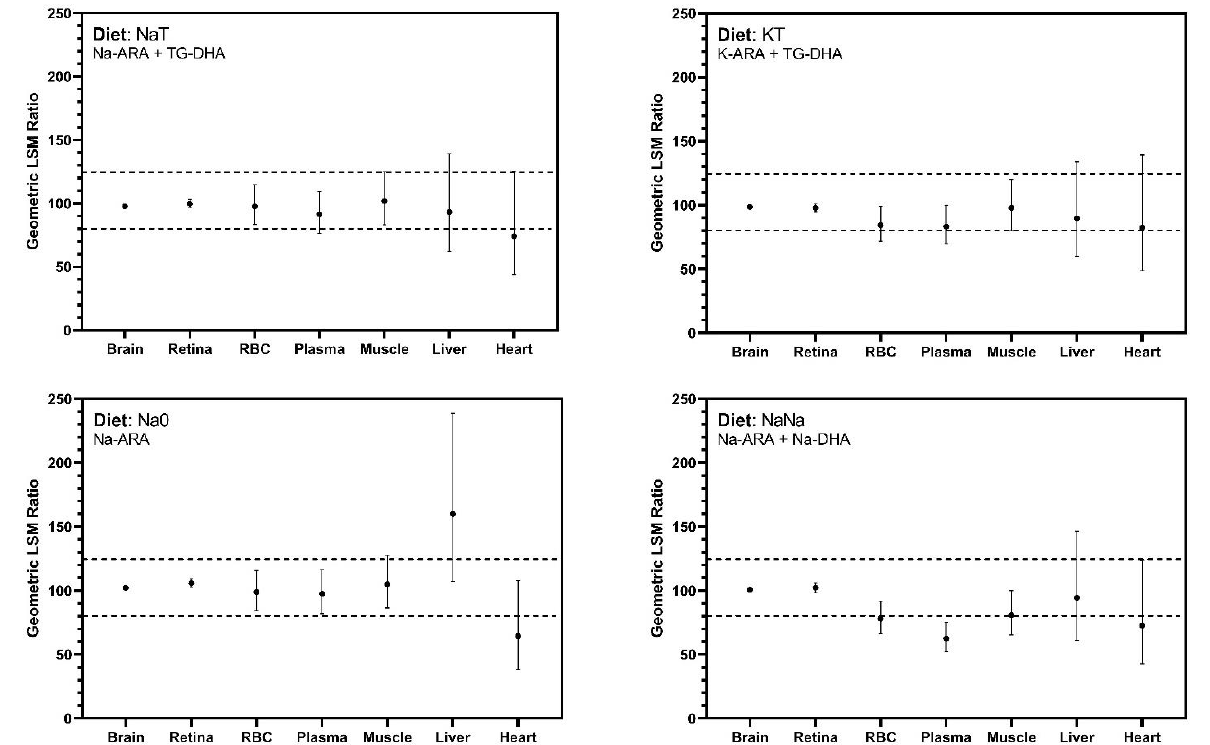
Figure 1. ARA bioequivalence assessments. Geometric least squares mean ratios of tissue ARA from dietary treatment group compared with the control (TT). Values presented as percentages and bioequivalence are met if 90% confidence intervals fall between 80–125% (horizontal dashed lines). All pigs received dietary treatments for 23 days. Abbreviation: ARA, arachidonic acid; DHA docosahexaenoic acid; LSM, least squares mean; TG, triglyceride.